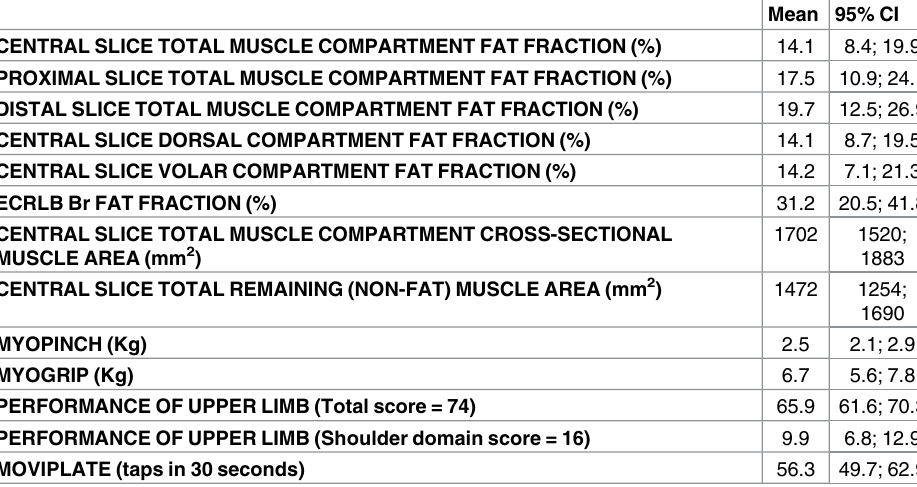
Table 1. Baseline characteristics of DMD